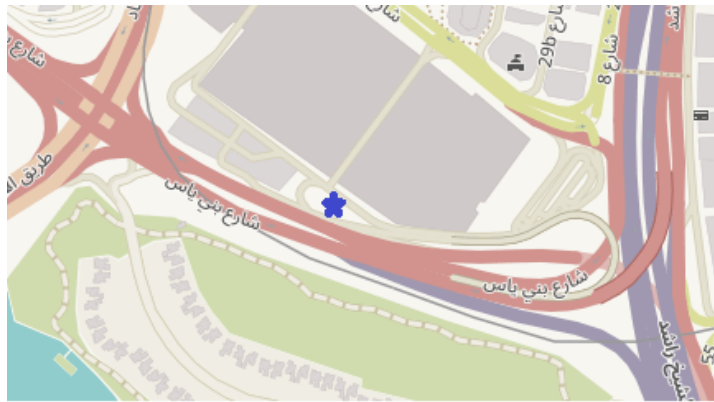
Figure 1. A motivational scenario of road infrastructure in Dubai city. The blue star in the middle is the Sink location. Different roads have red, gray, blue, pink color where sensors are